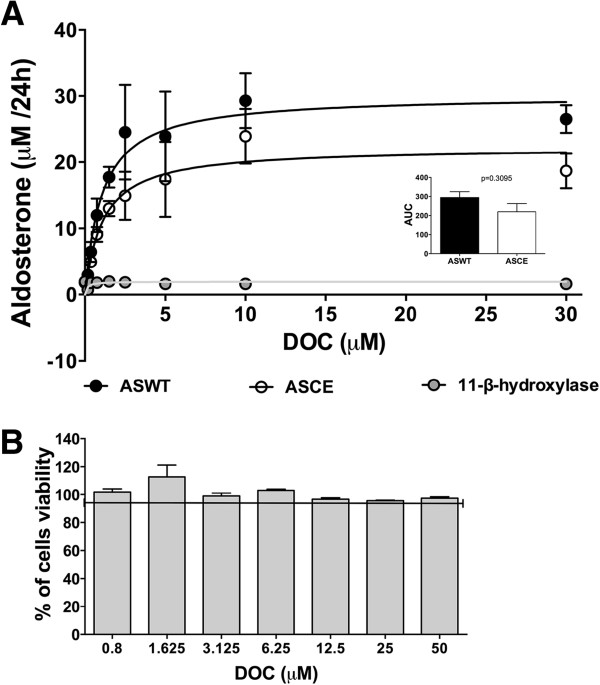
Enzyme kinetics of aldosterone production by ASCE and ASWT in vitro. A) Dose response curves of aldosterone production catalysed by ASCE (open circles), ASWT (closed circles) and 11β-hydroxylase (grey circles) incubated with 11-deoxycorticosterone (DOC 0.18-30 μM) for 24 h. Data are expressed as the mean +/− S.E.M. of 5 independent trials. The apparent kinetic enzyme parameters obtained were Km = 1.191 μM and Vmax = 27.08 μM/24 h for ASCE and Km = 1.163 μM and Vmax = 36.98 μM/24 h for ASWT, and the area under curve for each of the enzyme activities (ANOVA and Mann–Whitney test, p = 0.3095) is shown within the graph. B) Cell viability of HEK-293 incubated with increasing doses of DOC (0.8-50 μM).